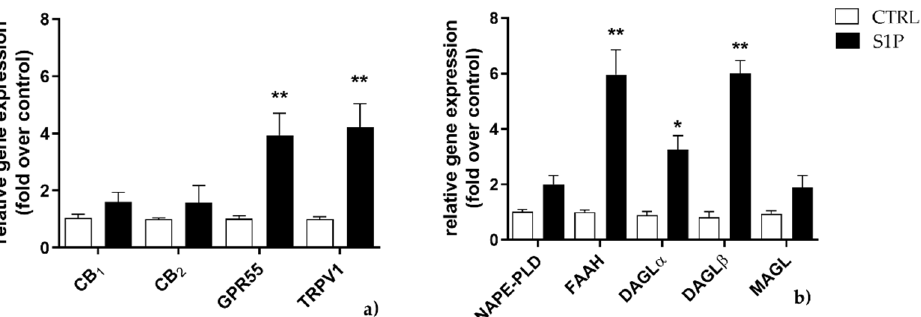
Figure 1. Effect of S1P on mRNA expression of endocannabinoid (eCB)-binding receptors ( a ) and metabolic enzymes ( b ) at 24 h. C2C12 cells were left untreated (in white) or were treated for 24 h with 1 µ M of S1P (in black). The values are expressed as 2 ( − ∆∆ Ct ) and normalized to β -Actin and GAPDH. Data are presented as means ± SEM ( n = 5). Statistical analysis was performed by TWO-WAY ANOVA test followed by Bonferroni post hoc test. [* p < 0.05, ** p < 0.01 vs. control cells (CTRL)].